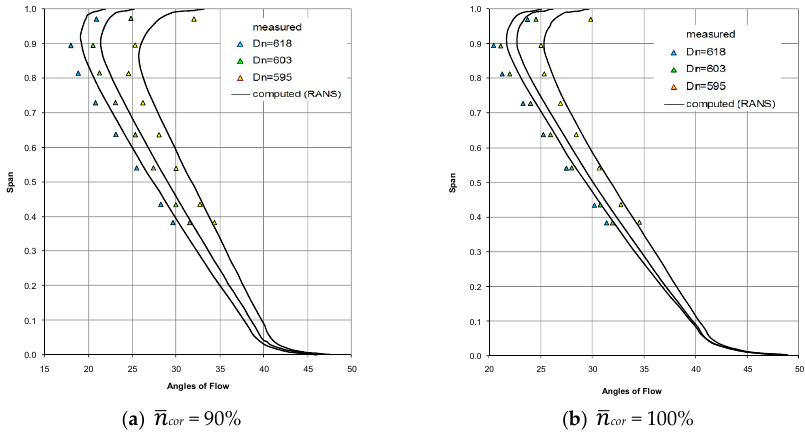
Figure 15. Comparison of computed (3D-RANS) and measured flow angles, α , at the R1 outlet. ( a ) n cor = 90%; ( b ) n cor = 100%.